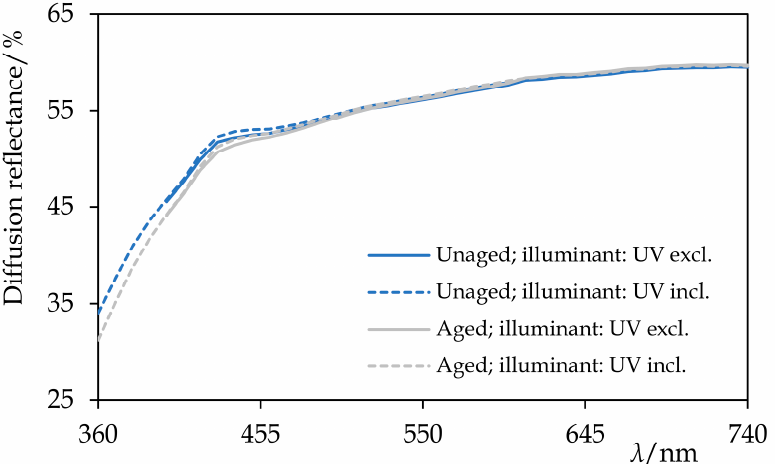
total color difference (CIE76).